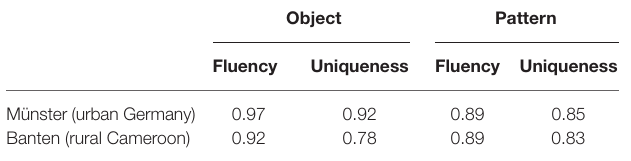
TABLE 1 | Consistency of fluency and unique responses across the five test items.